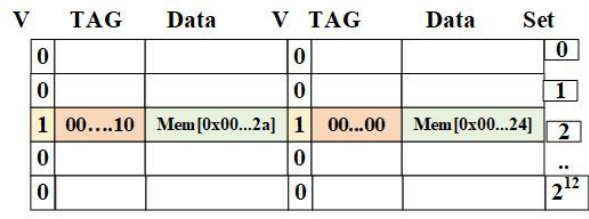
Figure 11. Cache content of 2-way set-associative system.